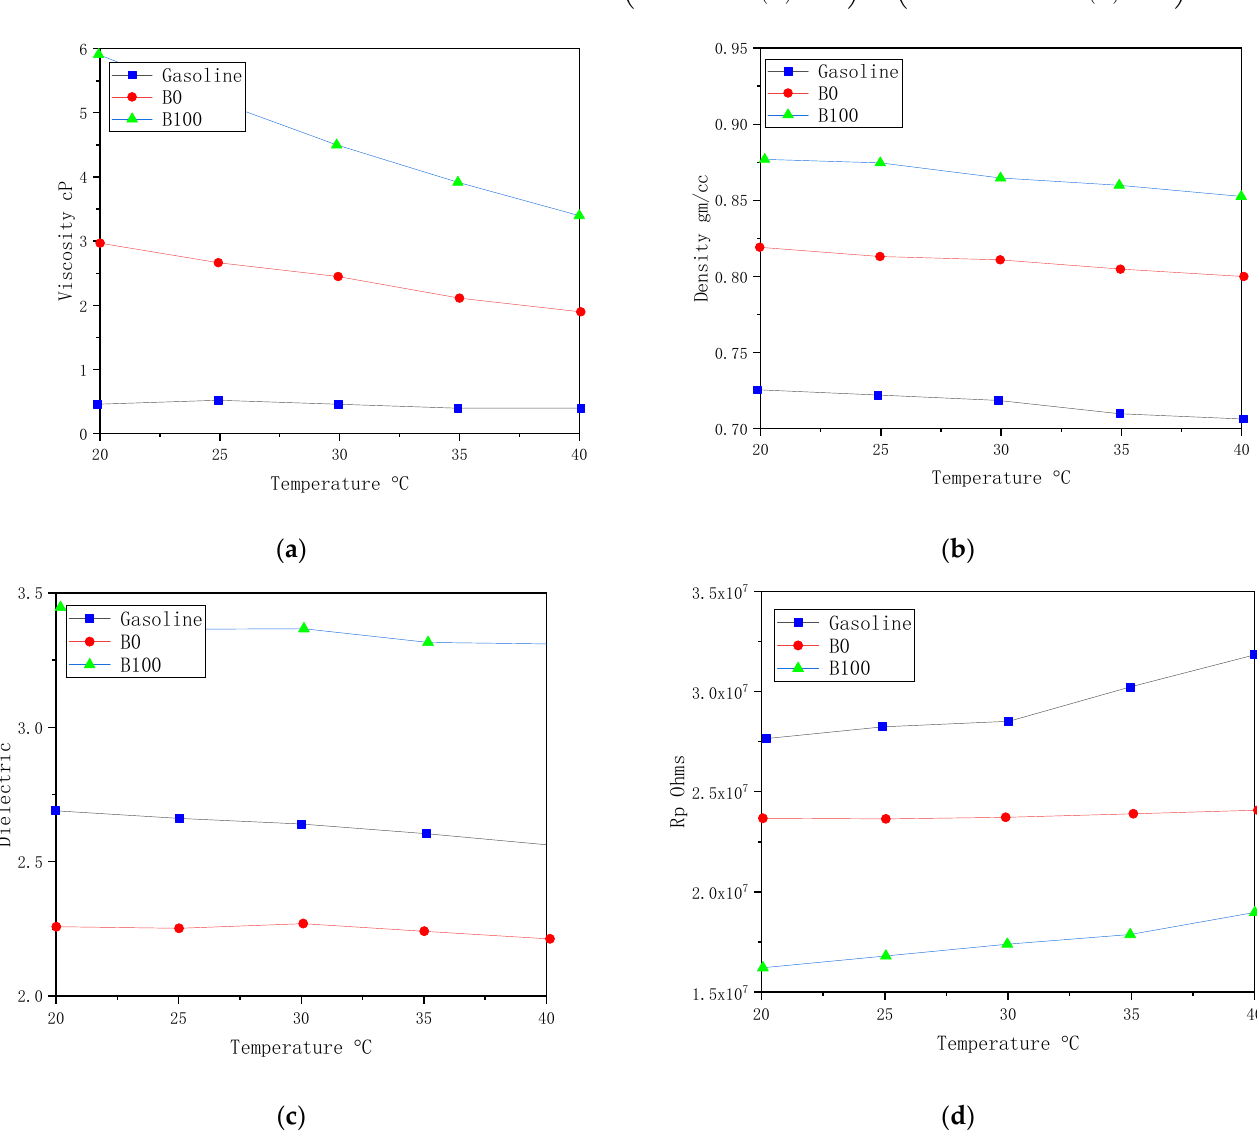
Figure 14. Gasoline, diesel B0, rapeseed B100 biodiesel: ( a ) viscosity; ( b ) density; ( c ) dielectric; and ( d ) Rp. B100 biodiesel has a higher viscosity, density, and dielectric value than pure petro-